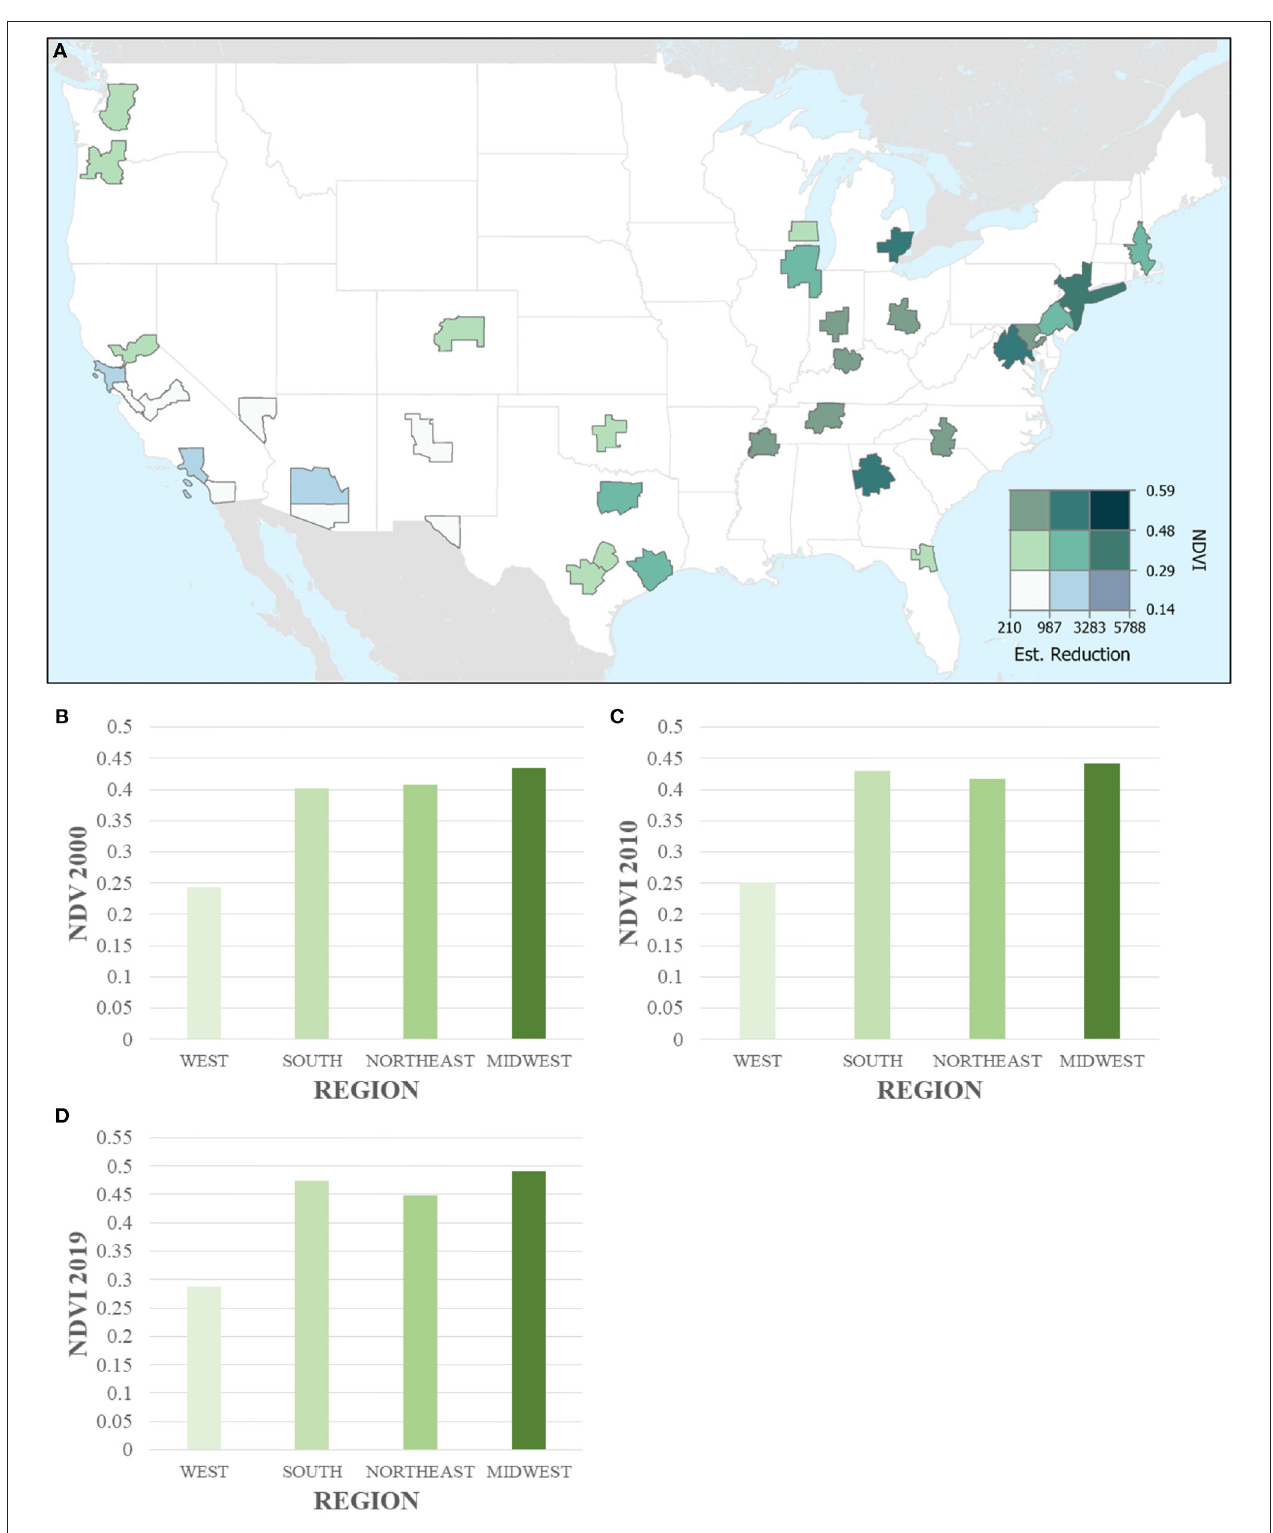
FIGURE 3 | Greenness and All-Cause Mortality Reduction for 2019 (A) Greenness (NDVI) and absolute estimated reduction in all-cause mortality across 35 CBSAs (aggregated up from 28,477 census tracts). CBSAs are represented by polygons. (B–D) Bar charts of greenness (NDVI) in 2000, 2010, and 2019 across the four regions in the US (aggregated up from census